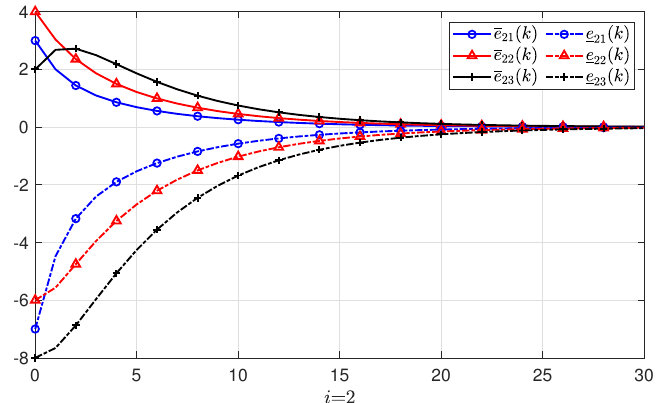
Figure 7. The simulations of state estimate errors e 2 ( k ) of the 2nd agent.